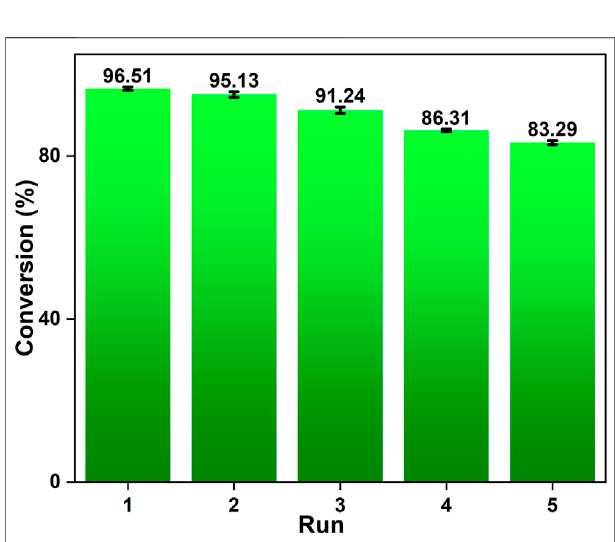
FIGURE 8 | Graphical representation of OP-SO 3 H-4 reusability in the esteri fi cation of oleic acid during 5 cycles (columns 1 – 5).